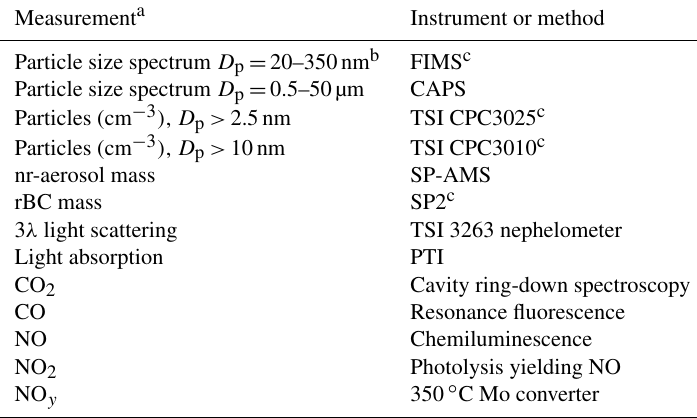
Table 1. Aerosol and trace-gas instruments on G-1 used in this study. Measurement